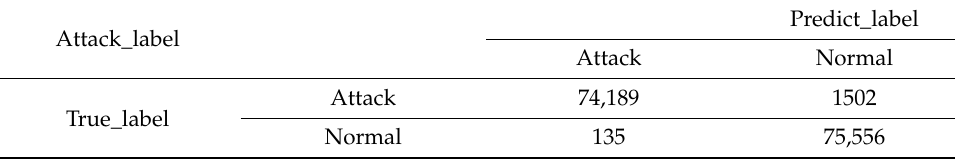
Table 7. Confusion matrix of UNSW-NB15 evaluating set.